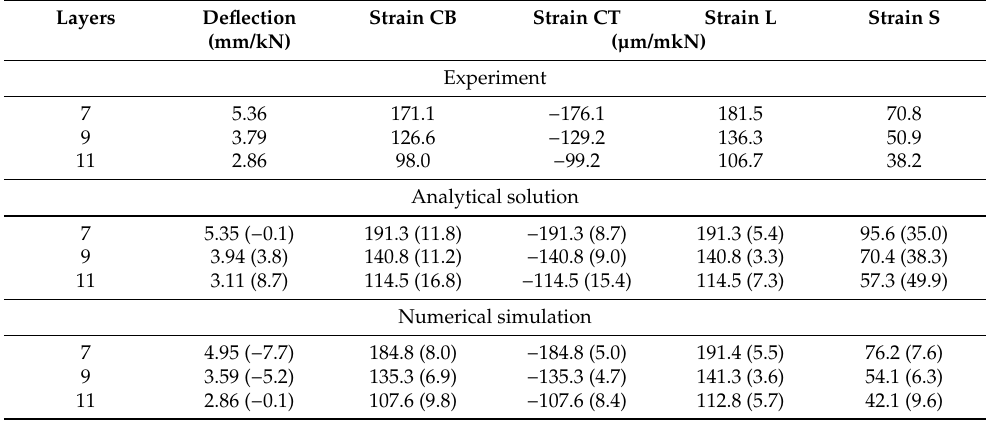
Table 3. Comparison of the measured and simulated values. Average values for experiment calculated from Table 2. Numbers in parentheses are percentage differences compared to the experiment. Layers Deflection Strain CB Strain CT Strain